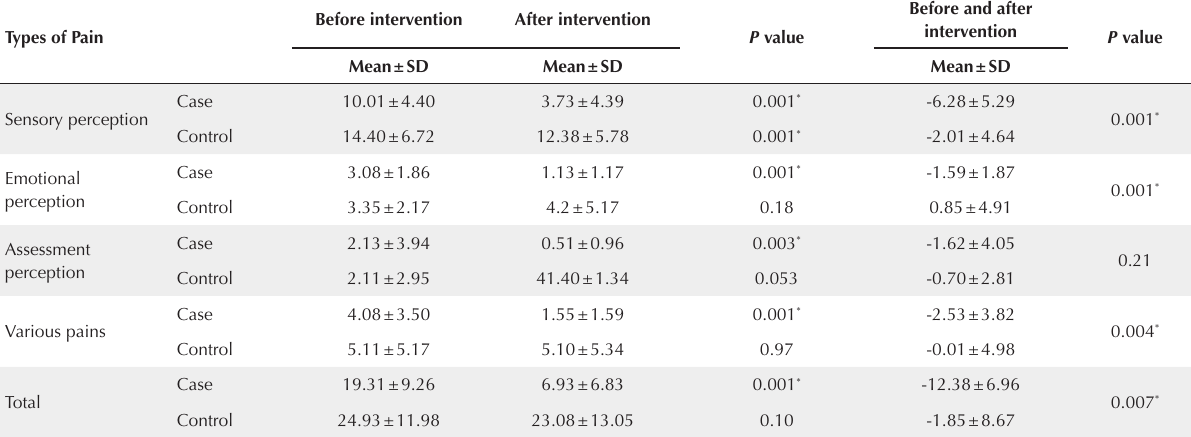
Table 2. The domination of pain intensity and mean score of participants before and after the intervention in the case and control groups Before intervention After intervention Types of Pain